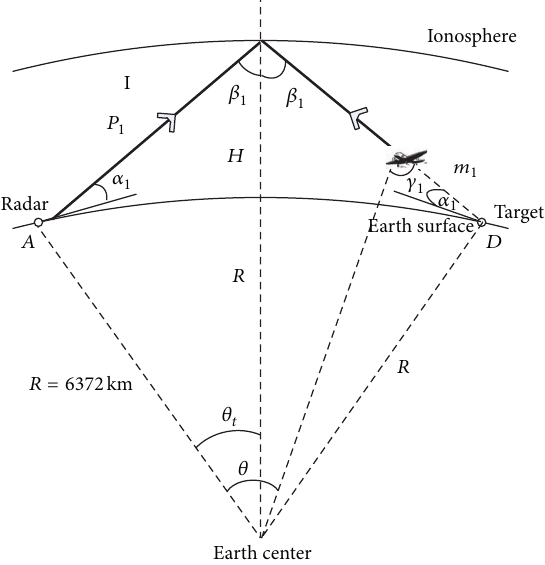
Figure 5: Path I in the earth curvature